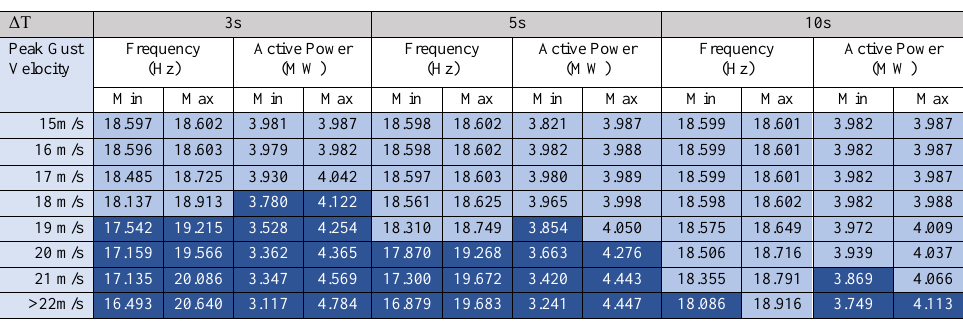
Table 5. This table displays the results of all EOG simulations completed. Light Blue demonstrates the respective responses remain within the ± 2.5% boundary limitations with dark blue showing the criteria has not been